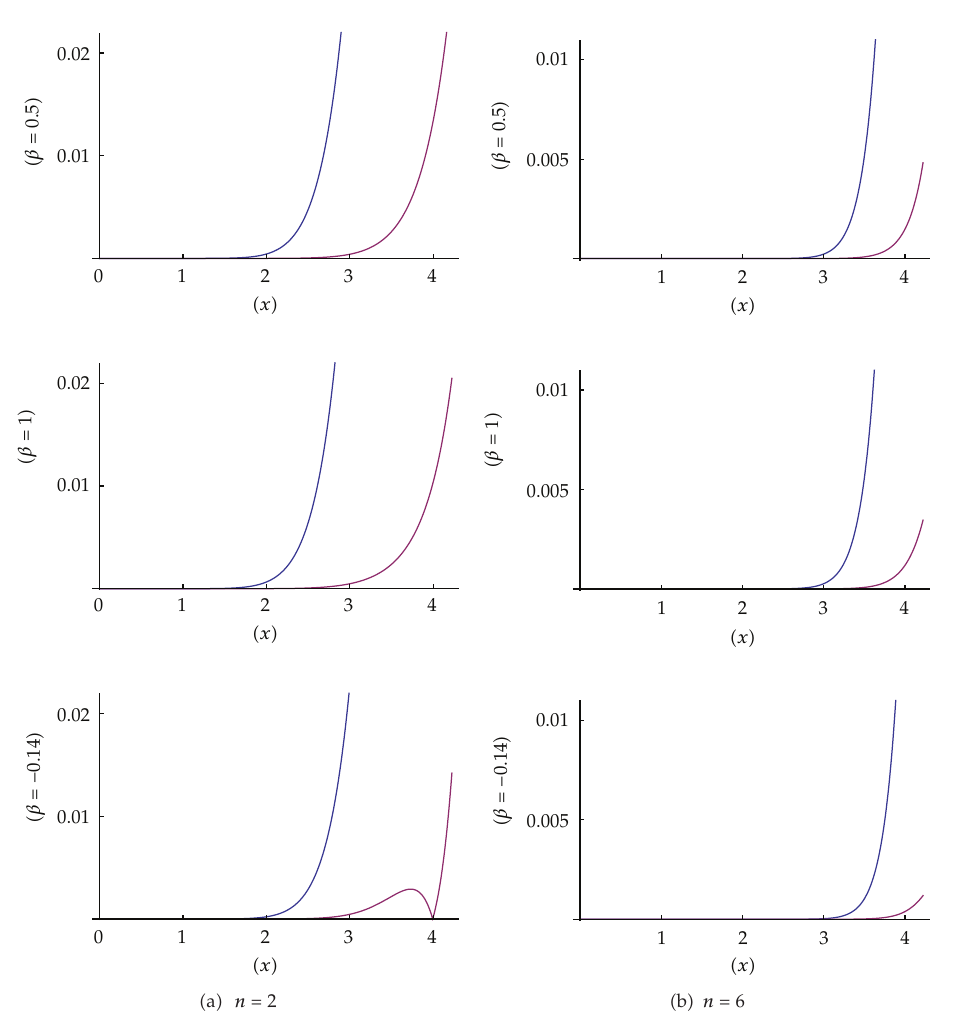
Figure 7: Absolute errors of the presented solutions y n (cid:5) 1 (cid:3) x (cid:4) (cid:3) thin lines (cid:4) and those of the corrected solutions (cid:24) y n (cid:3) x (cid:4) (cid:3) thick lines (cid:4) for β (cid:6) 0 . 5 , 1 , − 0 .